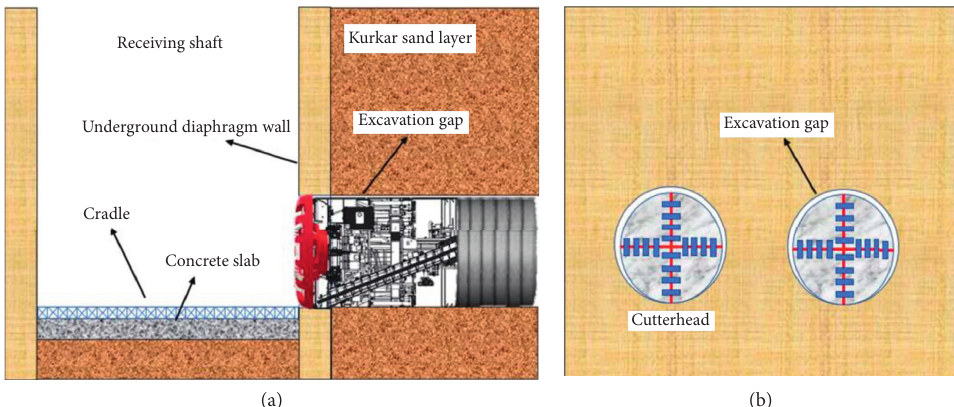
Figure 6: Schematic drawing of shield recovery in the shaft: (a) the shield breaking through the diaphragm wall and (b) the excavation